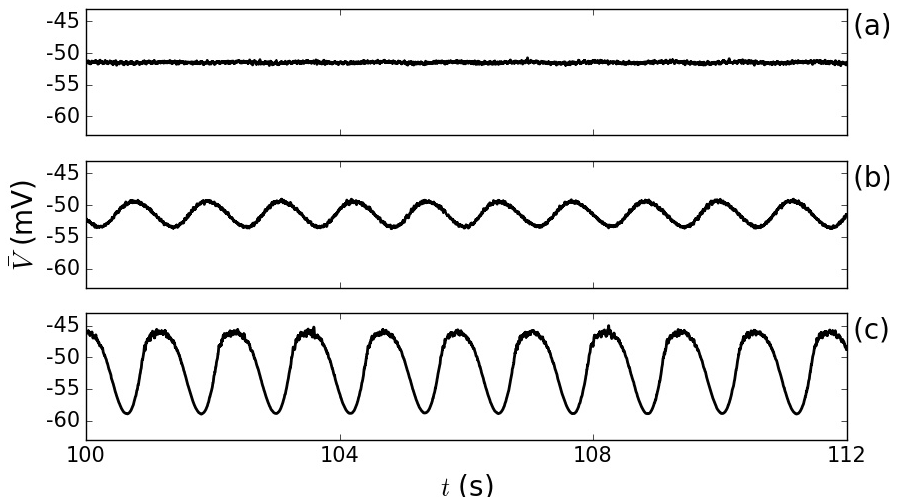
Figure 7. The evolution of the mean field ¯ V in time for: ( a ) ε = 0.001 (unsynchronized); ( b ) ε = 0.007 ( ≈ ε ∗ ); and ( c ) ε = 0.020 (synchronized).